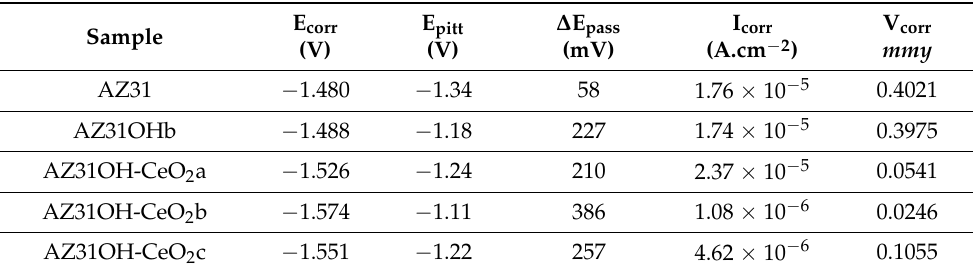
Table 6. Electrochemical parameter related to the polarisation curve of AZ31 anodised and modified at different concentrations of Ce 2+